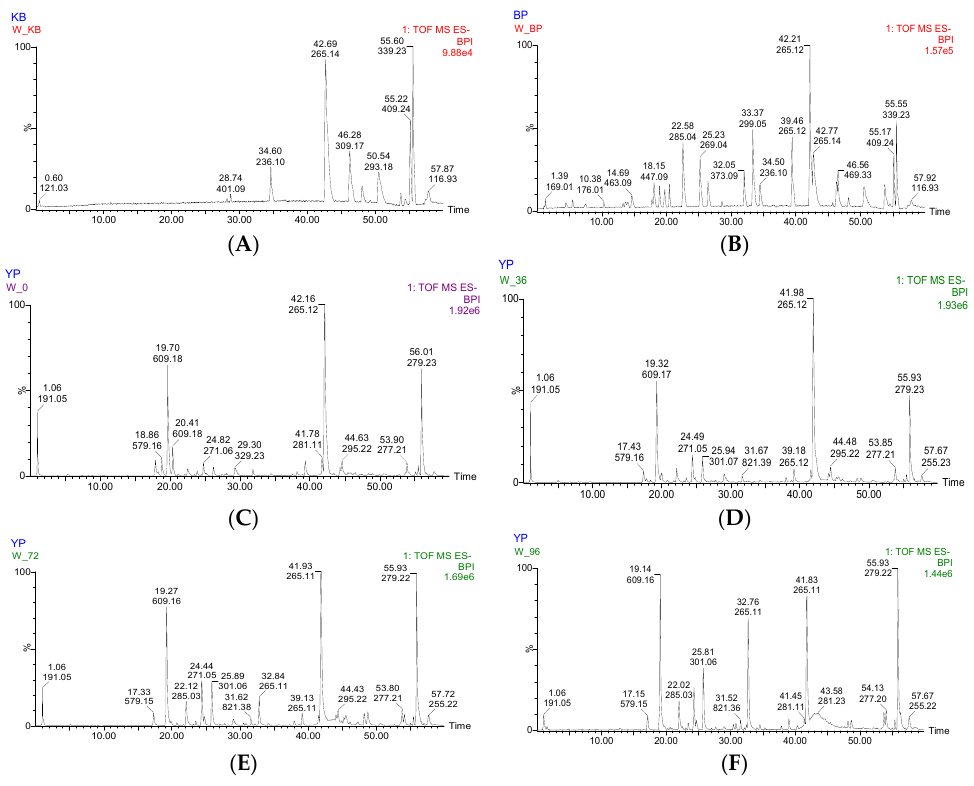
Figure 1. Base peak ion chromatograms of blank, standard, and Jianqu samples with different fermentation time in negative ion mode. ( A ) blank solution ( B ) reference solution ( C ) 0 h sample ( D ) 36 h sample ( E ) 72 h sample ( F ) 96 h sample. Table 4. UPLC-Q-TOF-MS/MS identification of compounds in Jianqu.